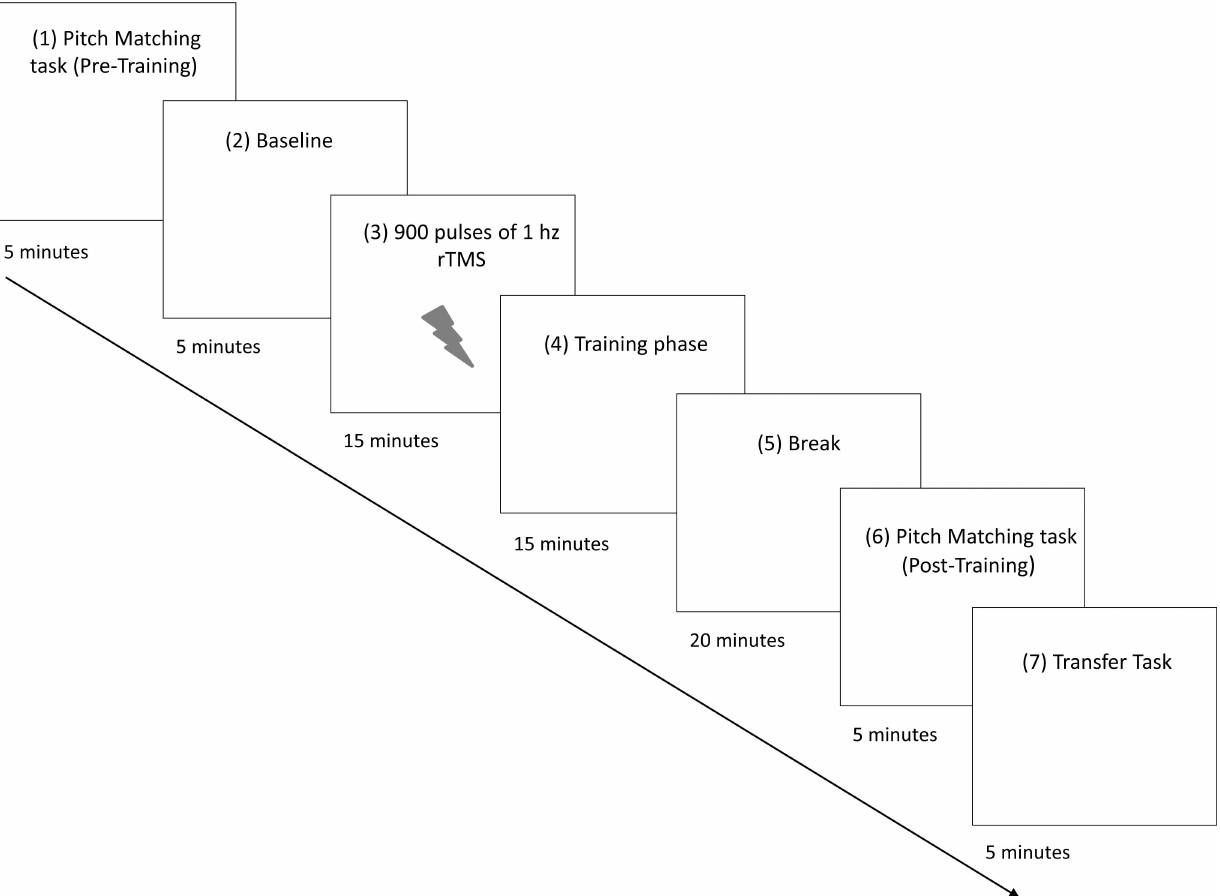
Fig 1. The timeline of the Experiment 1 and 2. Participants were asked to perform the Pitch-to-key press matching task (1) and the Baseline (2) task before the TMS stimulation.After that, 1 Hz rTMS was appliedover the dorsal premotor cortex (dPMC) and over the primary visual cortex (V1) (3) before the 3 Blocks of training(4). At least 40 minutes after the end of the stimulation (5) participants performed again the pitch- to-key press matching task (6) and the Transfer task (7).